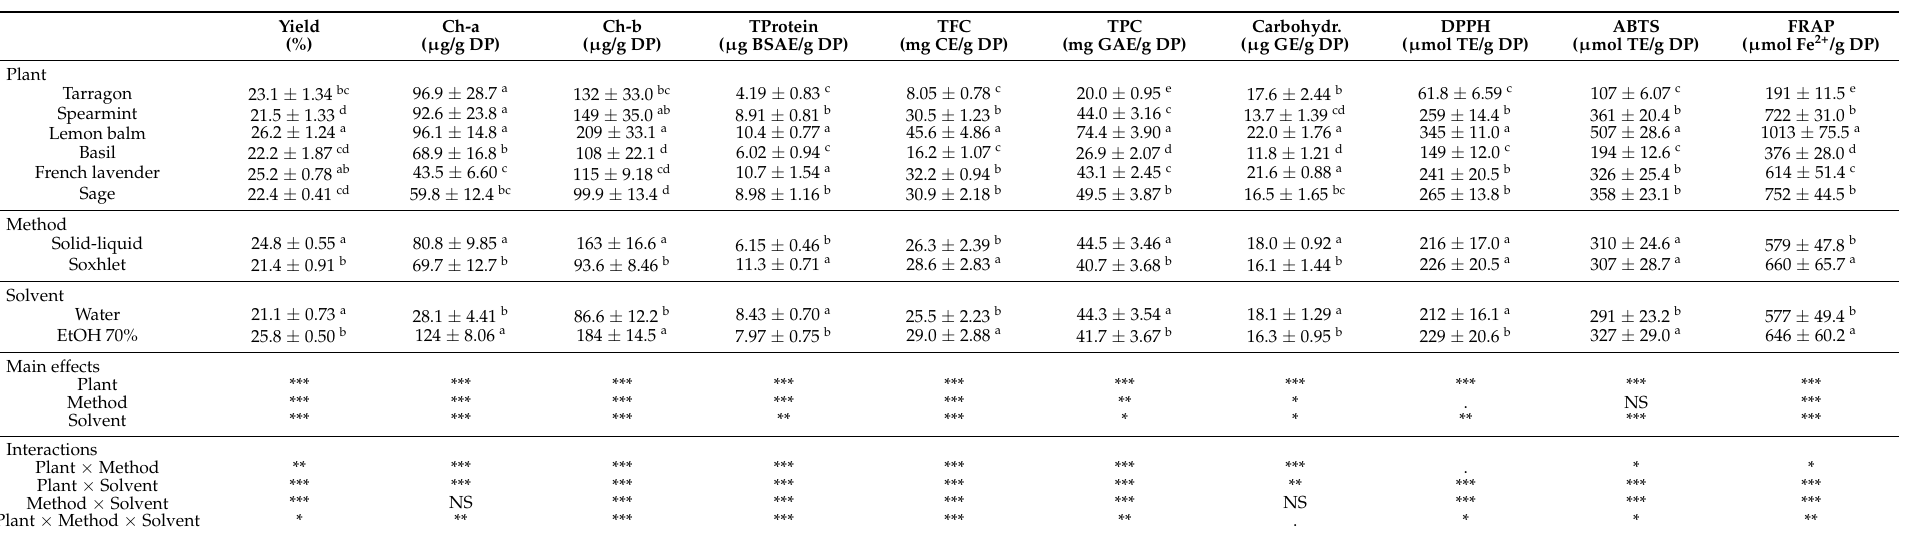
Table 1. Groupwise summary statistics (mean ± standard error) by plant, method, and solvent, for each chemical characterization and antioxidant assay, and significance of the main effects and interactions of the